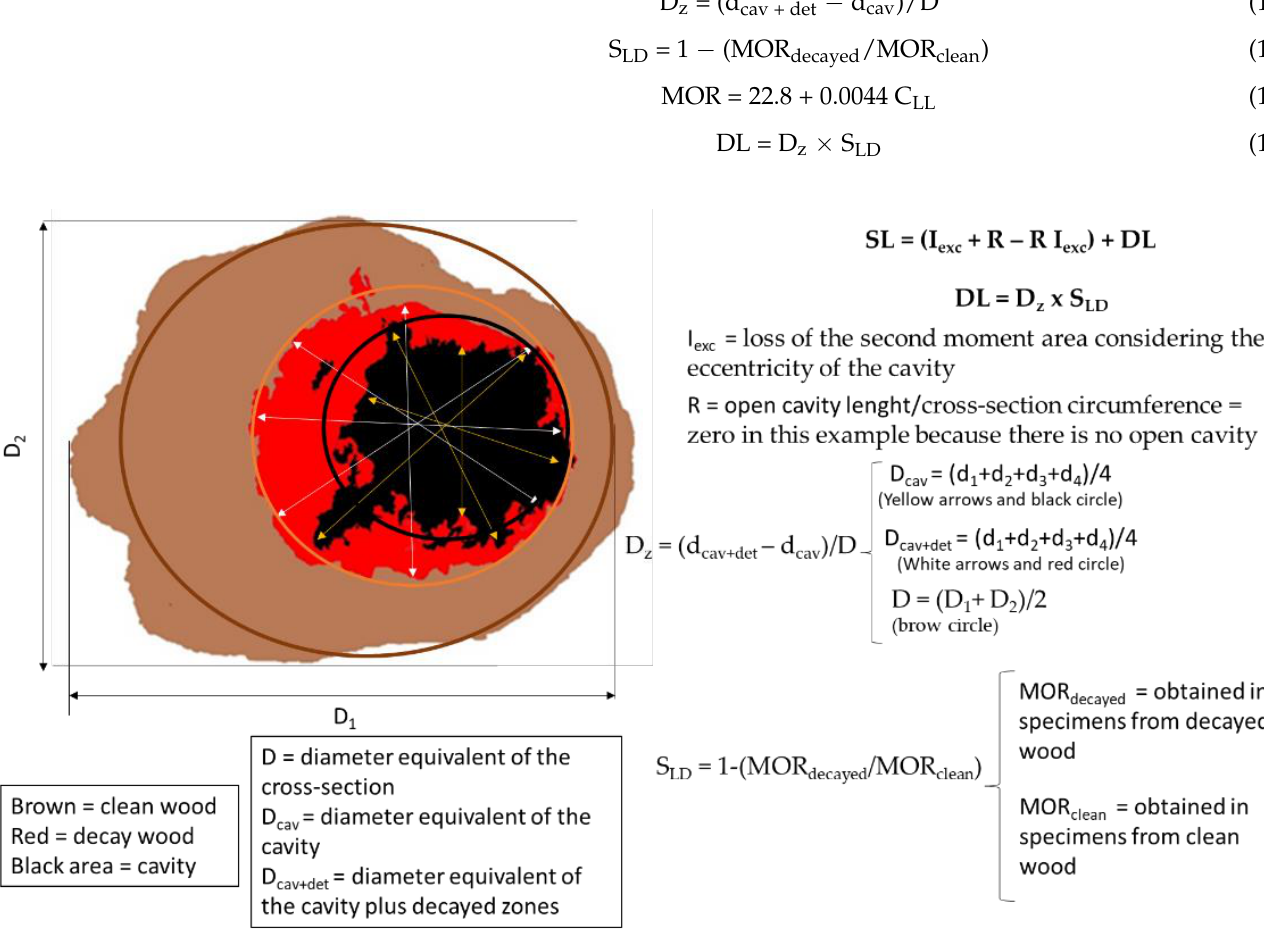
Table 1. Parameters calculated from the actual condition of the cross-sections (picture) and tomo- graphic image.